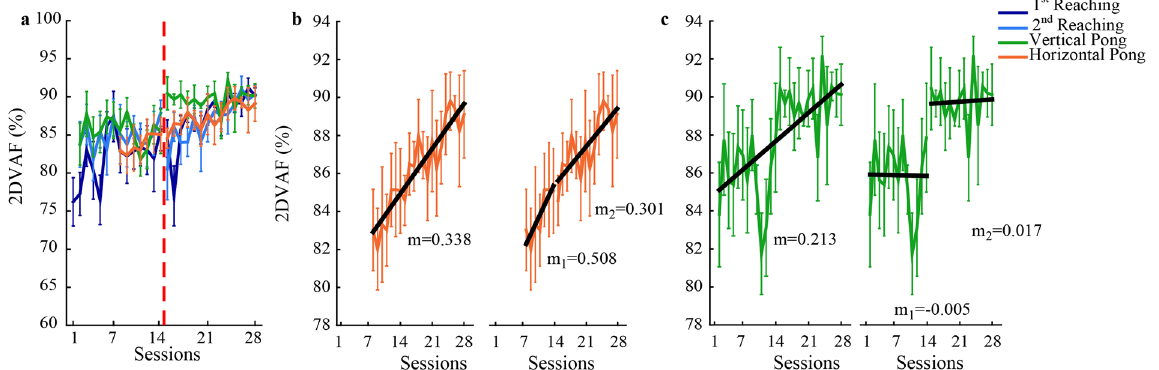
Figure 4. Evolution of the space representation. ( a ) Variance accounted for (2DVAF) of the first two eigenvectors extracted from the data set of the body movements during the 1 st and 2 nd block of reaching (shades of blue) and vertical and horizontal pong, respectively green and orange lines. The red dashed vertical line indicates the instant from where the changes at the interface occurred. ( b – c ) regression results from the 2DVAF extracted respectively during the horizontal and vertical pong. In both figures we report the regression line, grey, and its slope in case we consider the entire training period or we separately consider the two